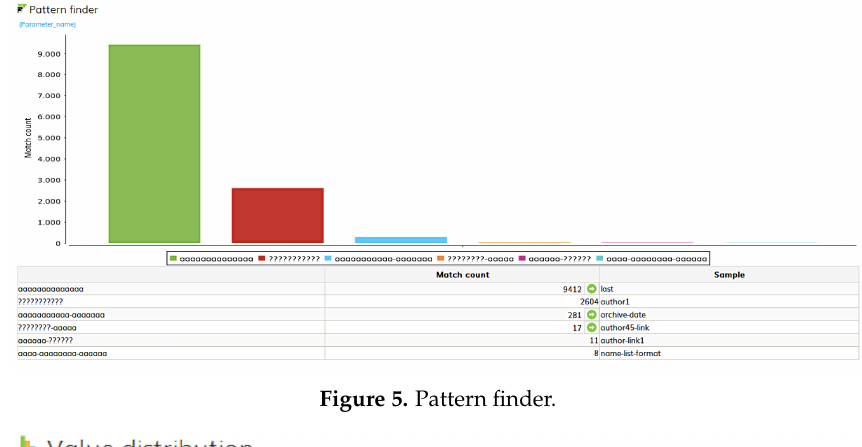
Figure 5. Pattern finder.